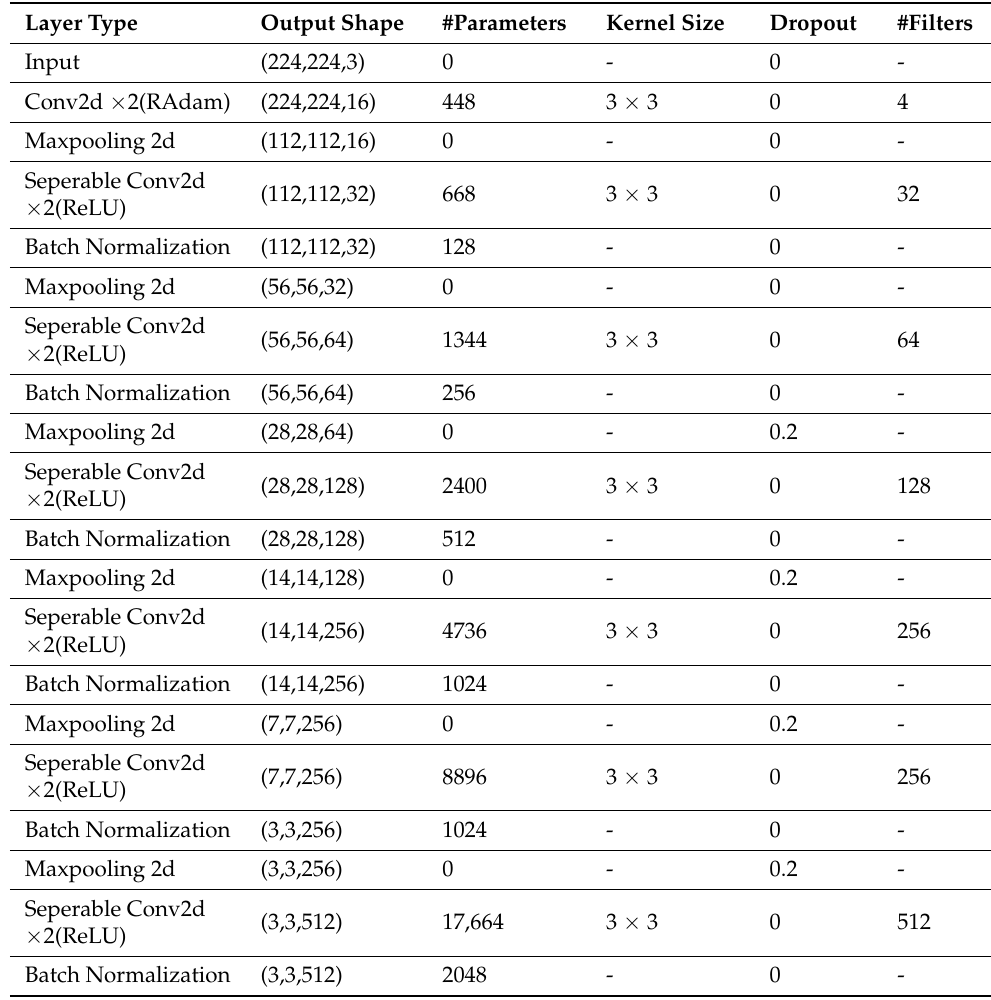
Figure 6. DenseNet block architecture. The architecture of the model used is shown in Table 1. Table 1. Architecture of DenseNet